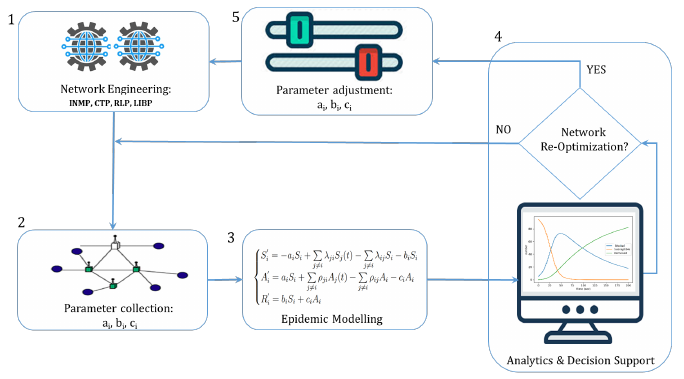
Figure 4. CPS monitoring